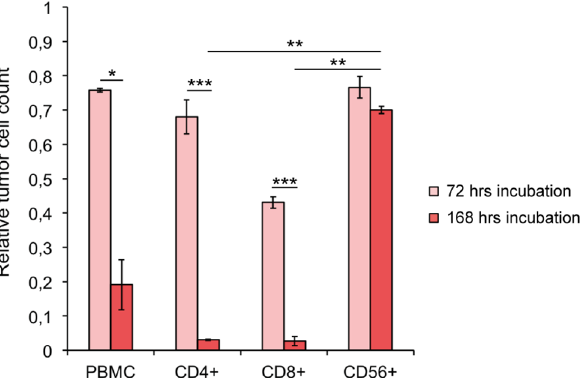
Fig 7. Killing efficiency of lymphocyte subpopulations. CSPG4 positive cells (A-375) were incubated with PBMC, CD4 + , CD8 + and a CD56 + enriched cell fraction, respectively, together with 1000 ng/ml monomeric r28M in a final volume of 150 μ l. The amount of viable tumor cells was determined after 72 and 168 hrs of incubation. Results show samples normalized to the controls. Cells incubated without r28M served as controls, their number was considered as 1. Values are means ± SE. Significance levels: x: p (cid:1) 0.05; xx: p (cid:1) 0.01; xxx: p (cid:1)